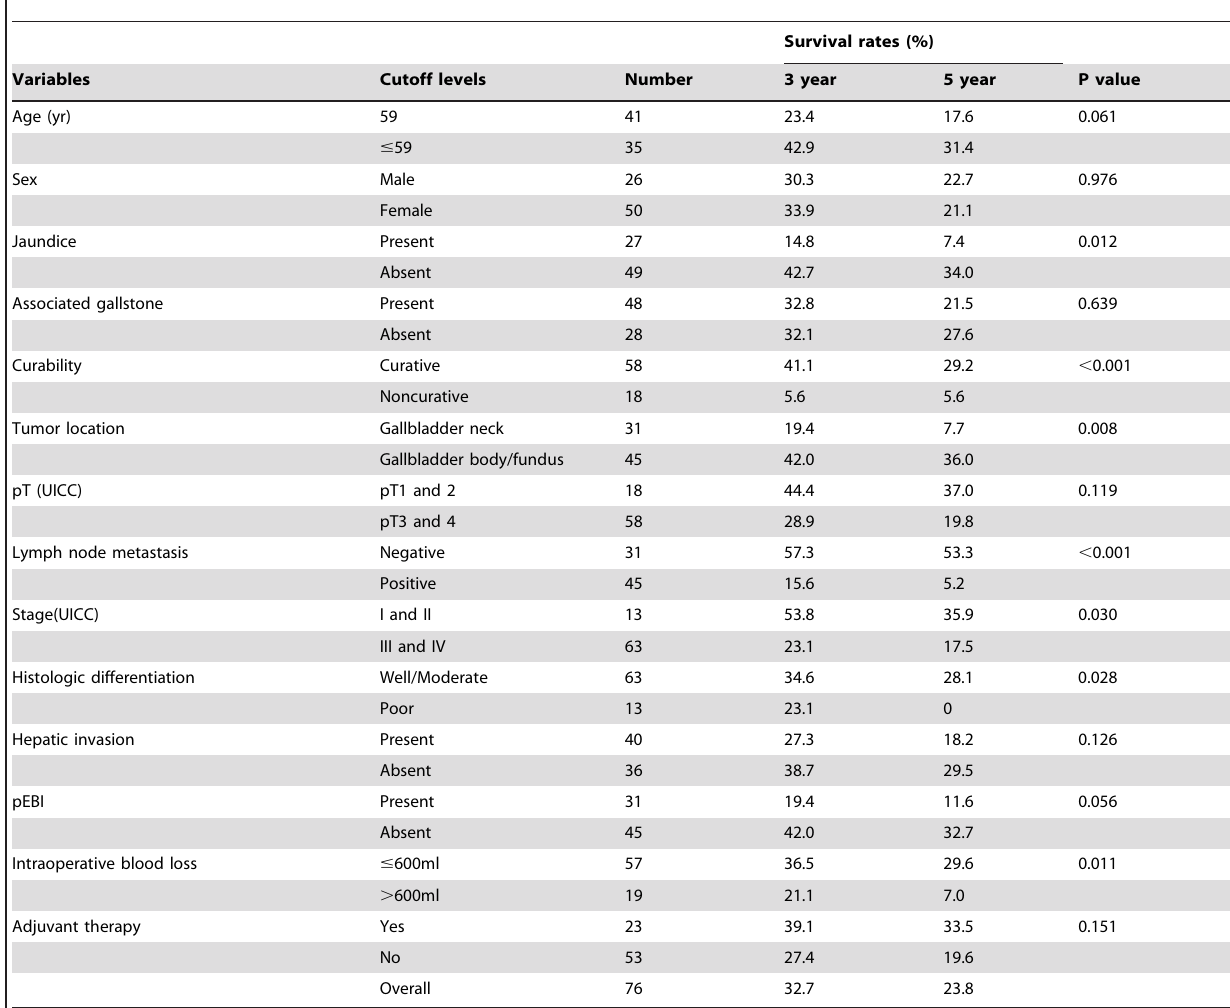
Table 4. Univariate analysis of 14 variables in relation to survival (76 cases).